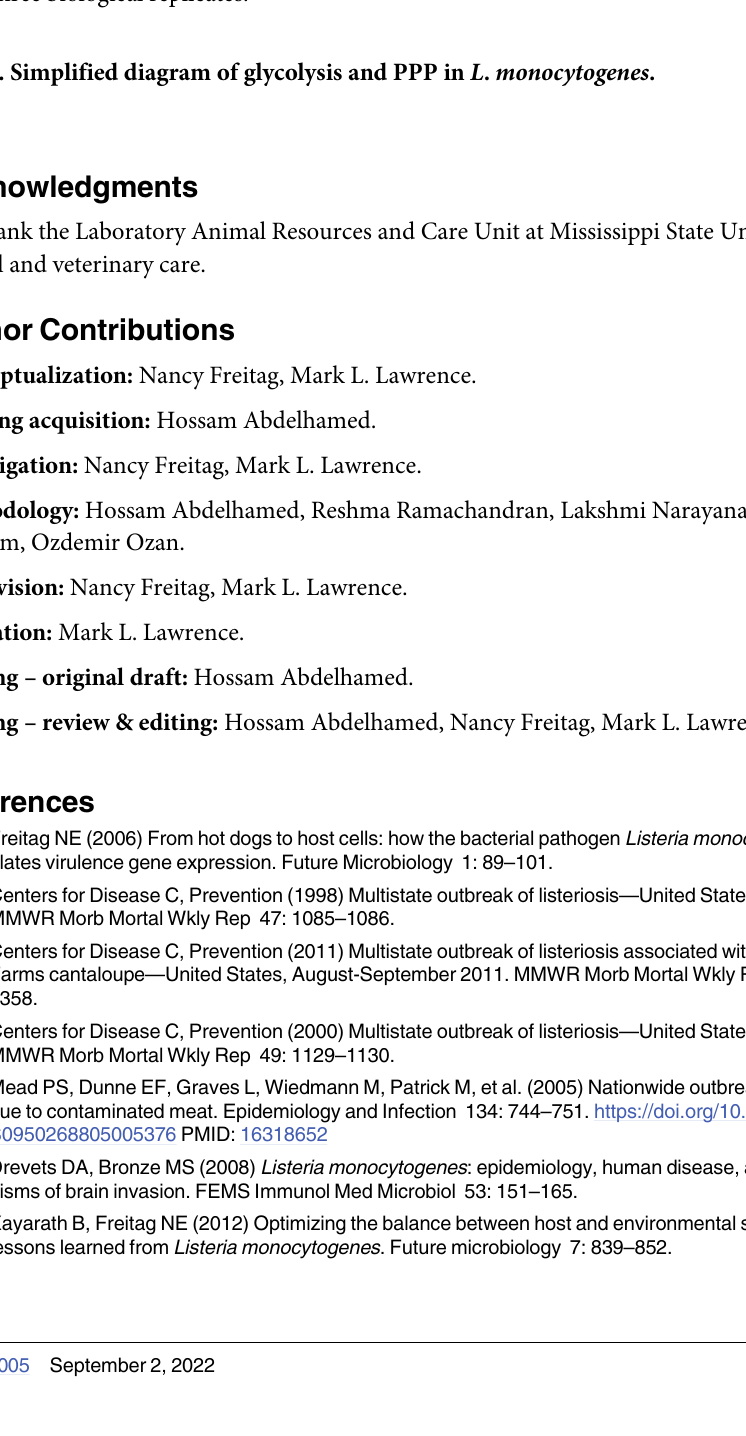
S4 Fig. Δ fruR strain exhibits normal growth patterns in MM supplemented with fructose (A), mannose (B), maltose (C), or sucrose (D) as a sole carbon source. Bacterial growth curves were determined by optical density measurements at 600 nm. All growth data are the results from three independent experiments with four replicates and the figure shows a representative experiment. Error bars represent SEM. Differences between Δ fruR strain and wildtype were not statistically significant (P > 0.05). S5 Fig. RT-PCR analyses of upregulated genes ( fruA and fruB ) and downregulated genes ( glck and rsbT ) in Δ fruR compared to wildtype. The data represent means ± standard errors from three biological replicates. S6 Fig. Simplified diagram of glycolysis and PPP in L . monocytogenes